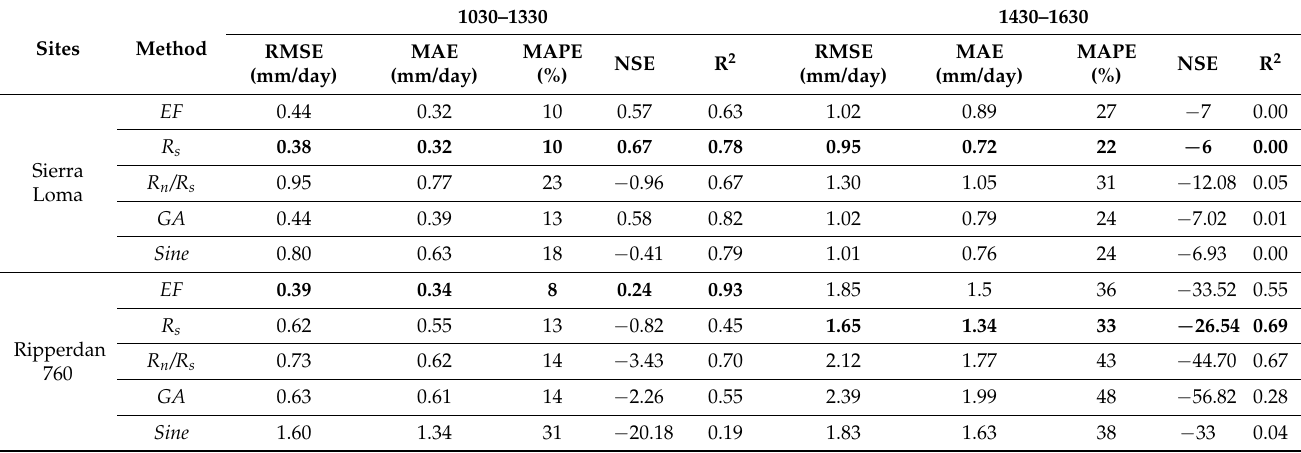
Table 5. Goodness-of-fit statistics comparing multiple daily ET methods at two different time windows (1030–1330 and 1430–1630).